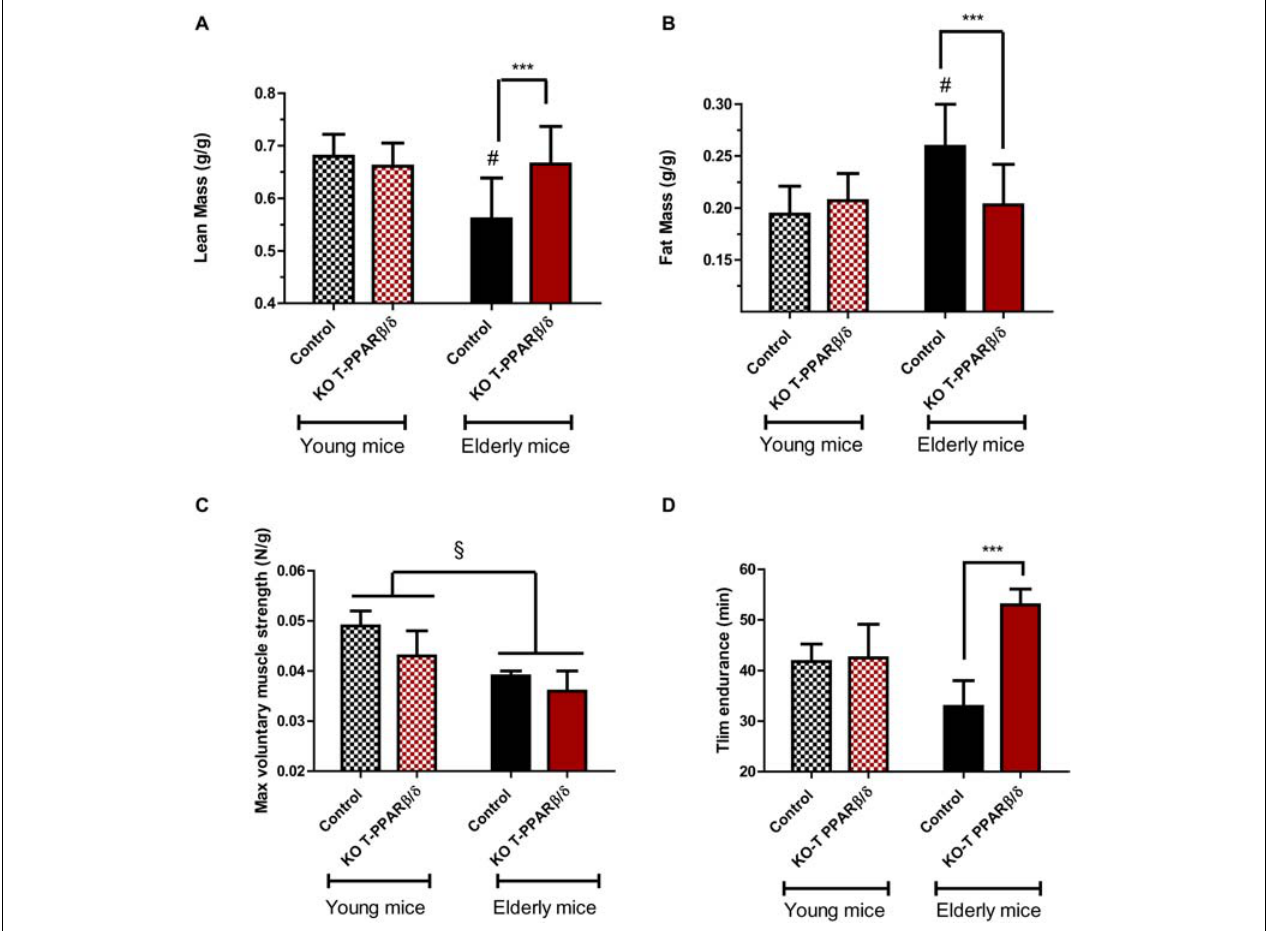
FIGURE 4 | Invalidation of PPAR β / δ in T cells preserves body composition and endurance capacities with age. Comparison of (A) lean and (B) fat mass, per weight of mice, according to age (young: 12–16 weeks, striped bars; older; 39–45 weeks, full bars) and genotype. Effect of age and genotype on (C) baseline maximal voluntary grip strength ( N per g of body weight) and on (D) exhaustive treadmill running time (Tlim). Values are mean ± SD. Statistical analysis was performed using a two-way (age and genotype) analysis of variance (ANOVA). # p < 0.05, different from control young mice; *** p < 0.005, different from age-matched control mice. § p < 0.05, different from young animals. Young control ( n = 11); young KO-T PPAR β / δ ( n = 8); older control ( n = 7); older KO-T PPAR β / δ ( n =